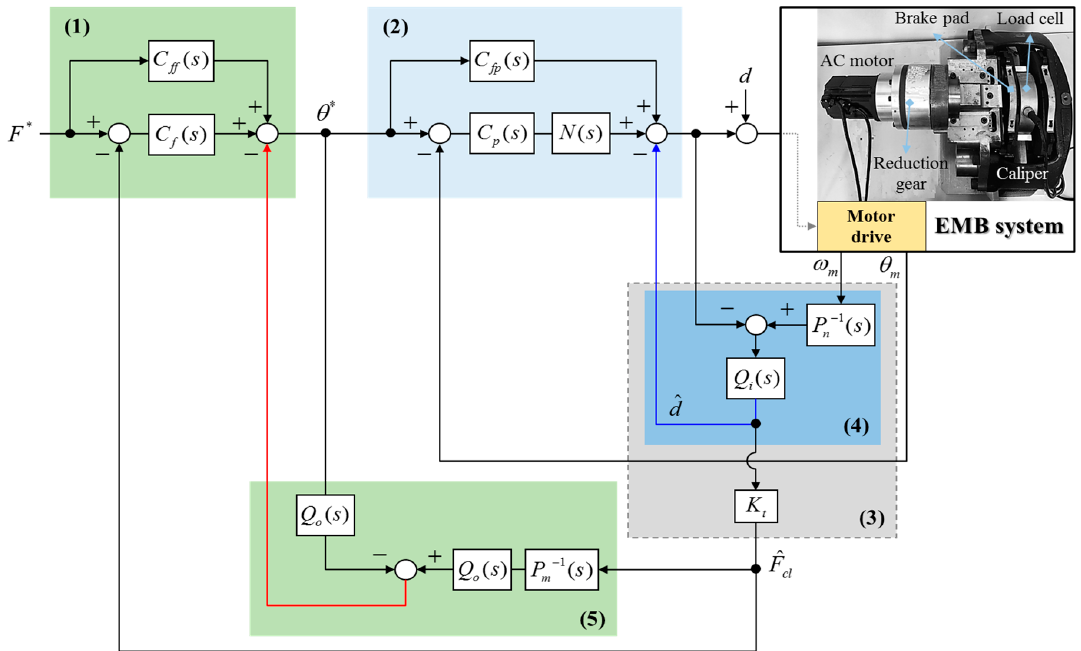
Figure 5. Overall structure for a proposed robust clamping force control system: ( 1 ) 2-degree-of- freedom clamping force controller; ( 2 ) 2-degree-of-freedom position controller; ( 3 ) Clamping force observer; ( 4 ) Position-mode DOB; ( 5 ) Force-mode DOB.